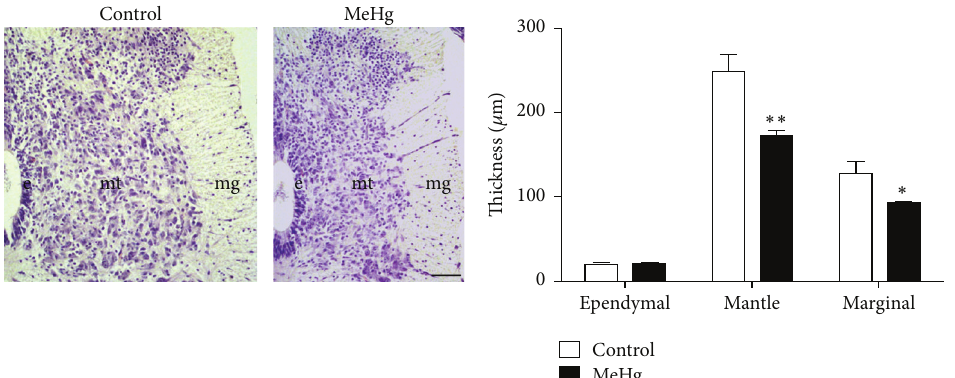
Figure 2: Thickness of the spinal cord layers in embryos at E10. Observe the evident difference in the size of the spinal cord between the control and MeHg-treated embryos. The graph displays the effect of MeHg treatment on the ependymal, mantle, and marginal layers. Data are expressed as mean ± SEM. ∗ 𝑃 < 0.05 and ∗∗ 𝑃 < 0.01 . e: ependymal layer; mg: marginal layer; and mt: mantle layer. Scale bar: 10 𝜇